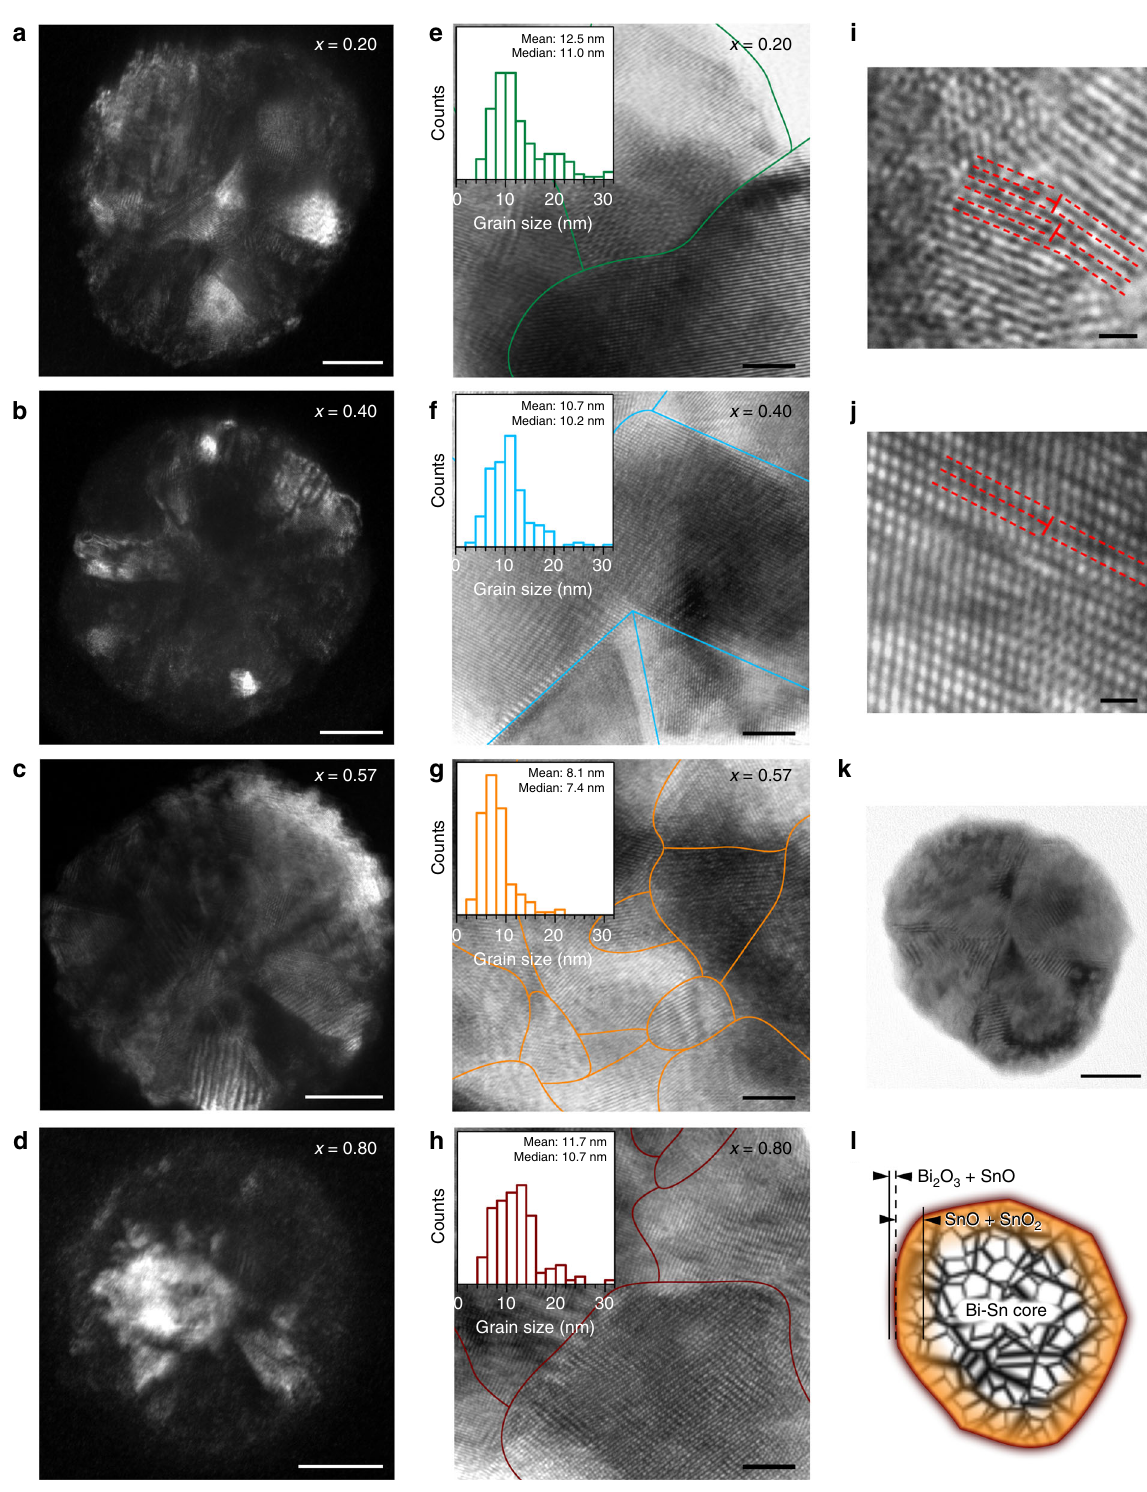
Fig. 5 Crystallographic characterisation of the Bi x Sn 1 − x nano-alloys. a – d DF-TEM images of individual particle of different Bi – Sn nano-alloy samples. Scale bars: 20 nm. e – h BF-HR-TEM images of the nano-alloys with their grain boundaries outlined. The insets present their respective grain size distribution. Scale bars: 5 nm. i , j BF-HR-TEM images showing line defects (edge dislocations) indicated by T-shape symbols that observed in the eutectic nano-alloys. Scale bars: 1 nm. k , l TEM image of a eutectic nano-alloy particle ( k ), scale bar: 20 nm, and an illustration shows its heterostructures based on the characterisation results ( l